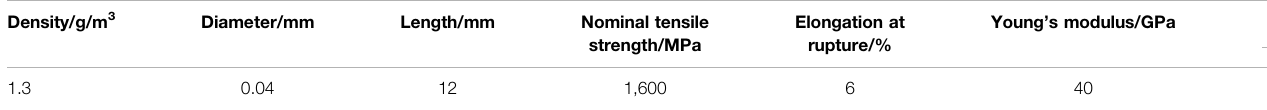
TABLE 2 | Characteristics of PVA fi ber.